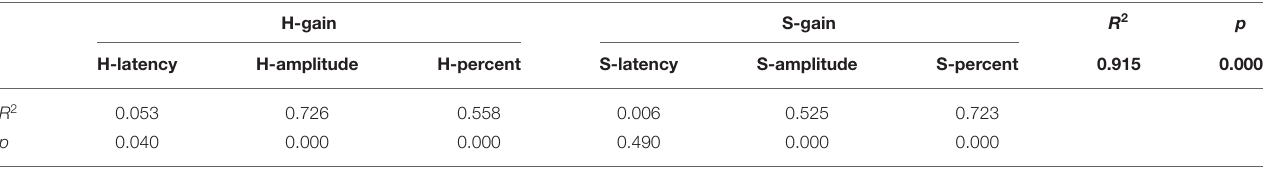
TABLE 4 | Correlational analysis of gain with other parameters in HIMP and SHIMP ( n = 80). H-gain S-gain R 2 p H-latency H-amplitude H-percent S-latency S-amplitude S-percent 0.915 0.000 R 2 0.053 0.726 0.558 0.006